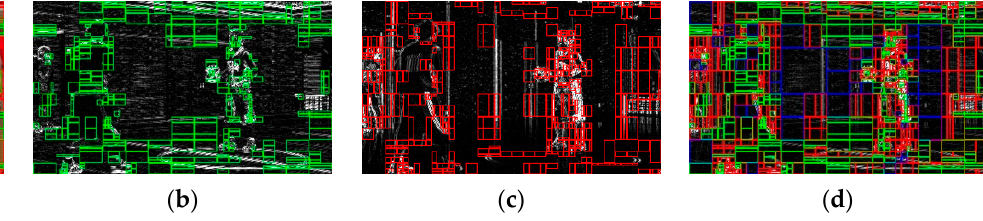
Figure 3. Original, sample-wise gradients, and activity with overlapping block partitions (Blue boxes: QT, Green boxes: BT-/TT-H, and Red boxes: BT-/TT-V): ( a ) Original; ( b ) Horizontal split with g v ; ( c ) Vertical split with g h ; ( d ) All split with A